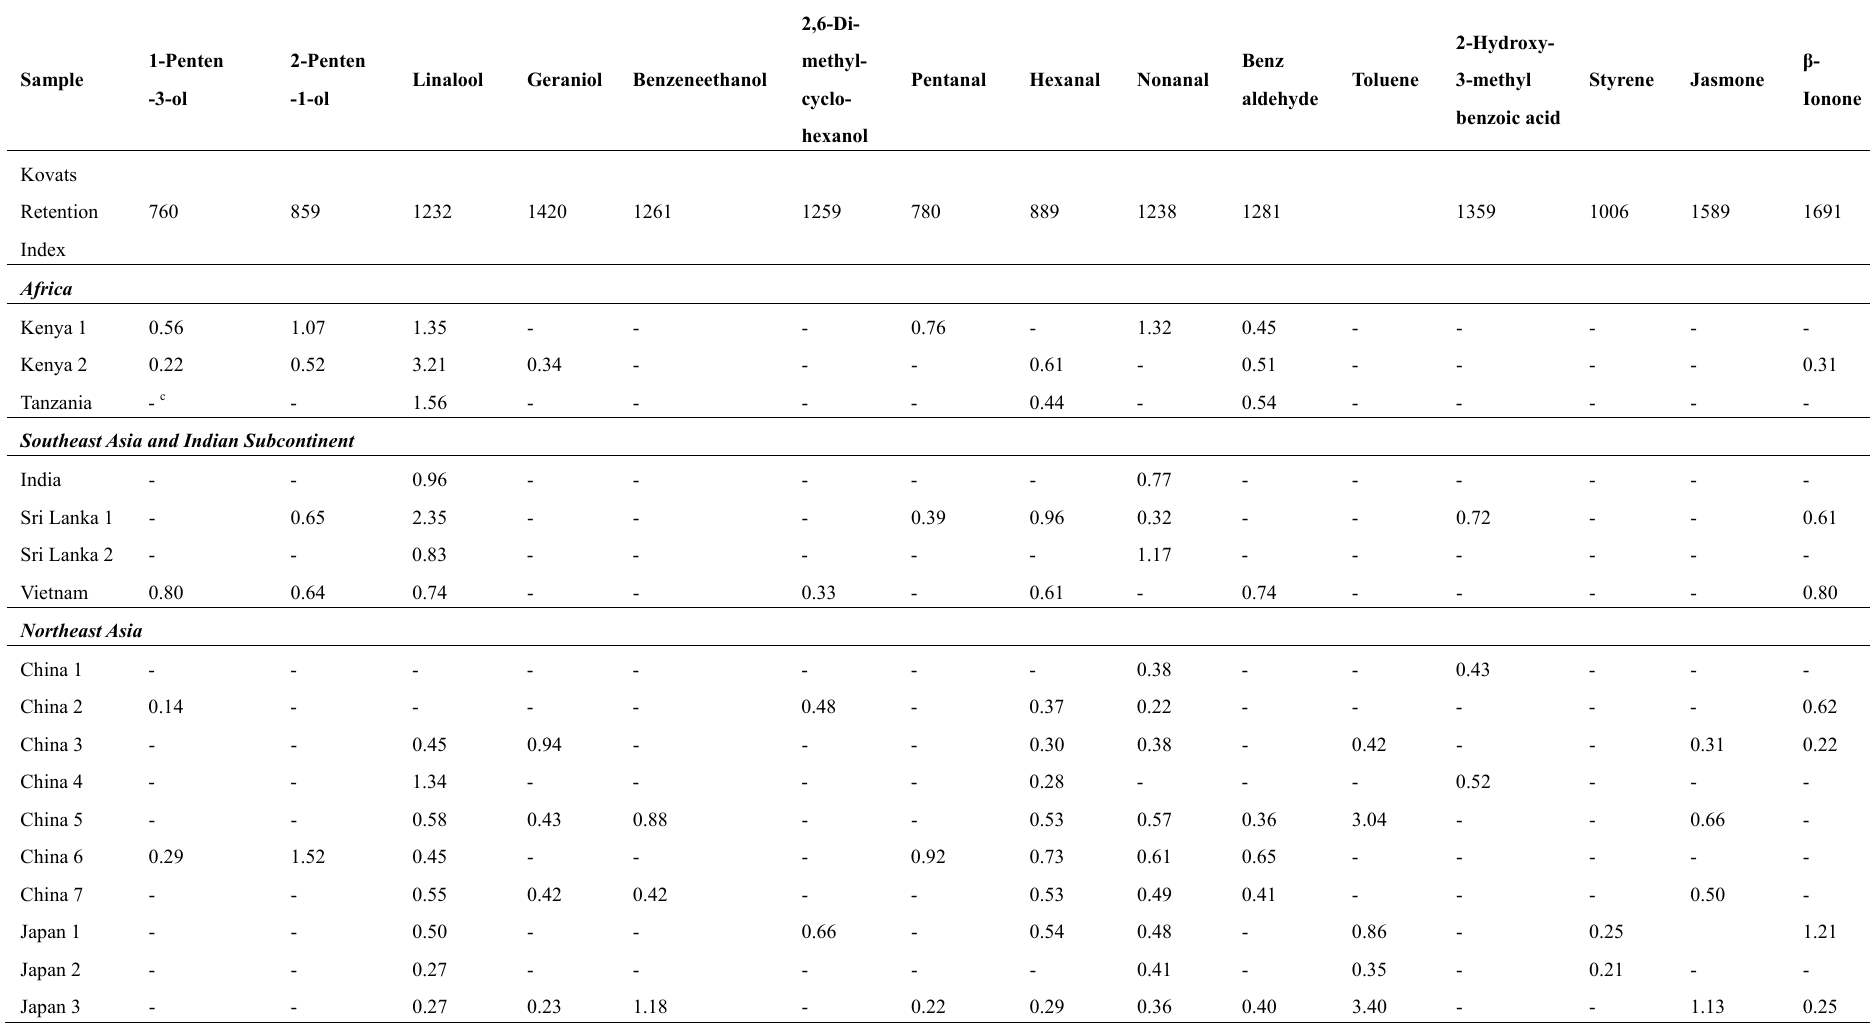
Table 2. Average concentration of 14 common volatile compounds identified in the brewed green tea samples (ng/kg) a,b